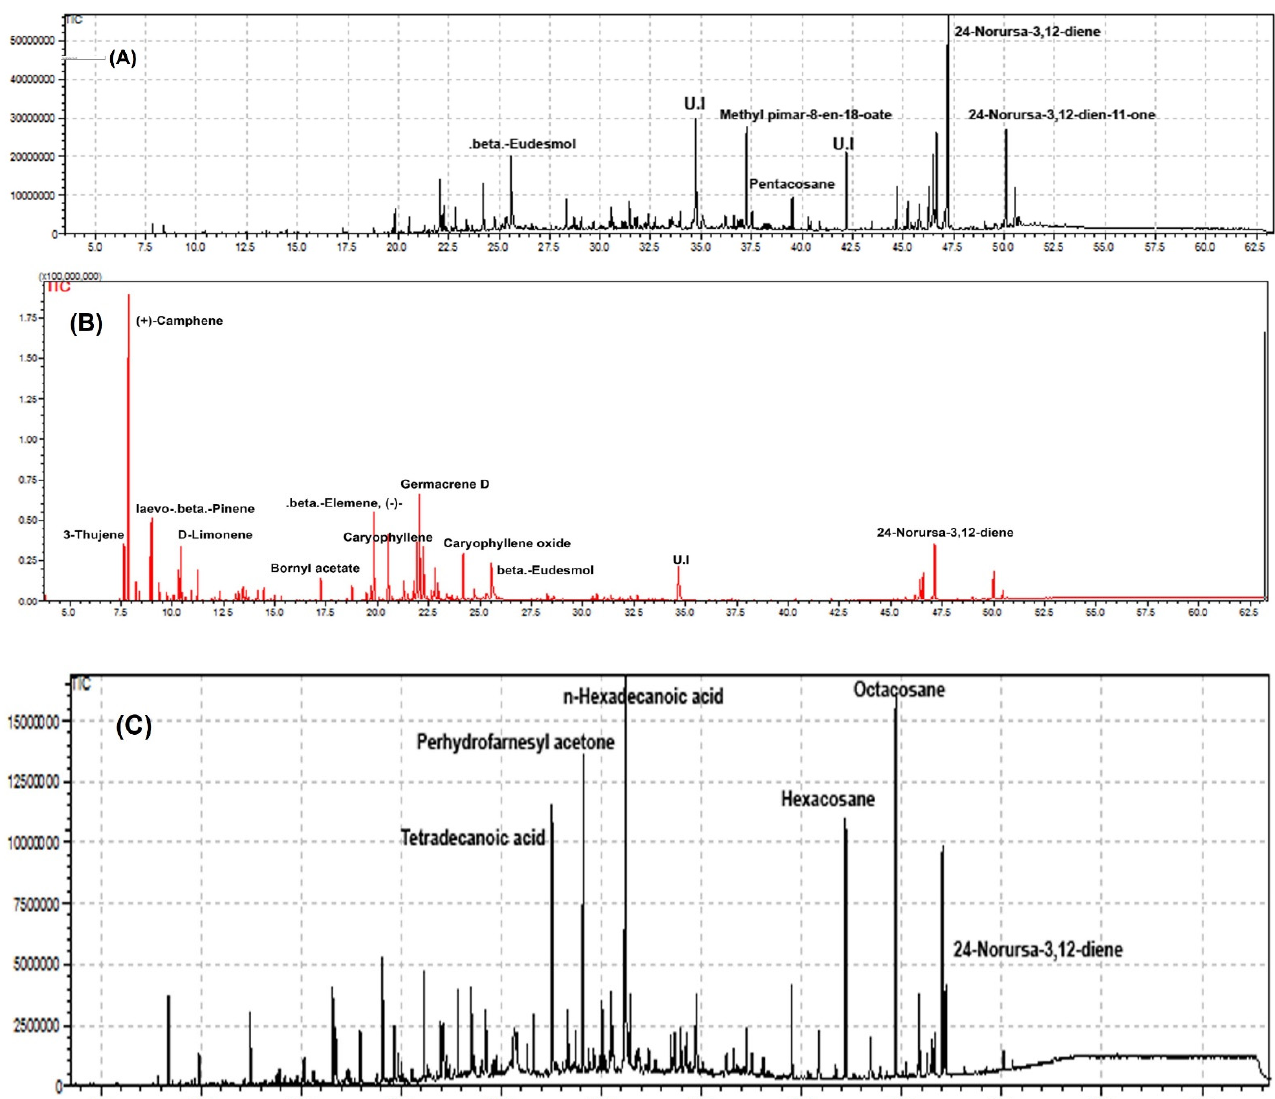
best knowledge, for the first time from the flowers essential oil of O. arabicus , while having been earlier documented in the literature for the genus Boswellia [18–20].